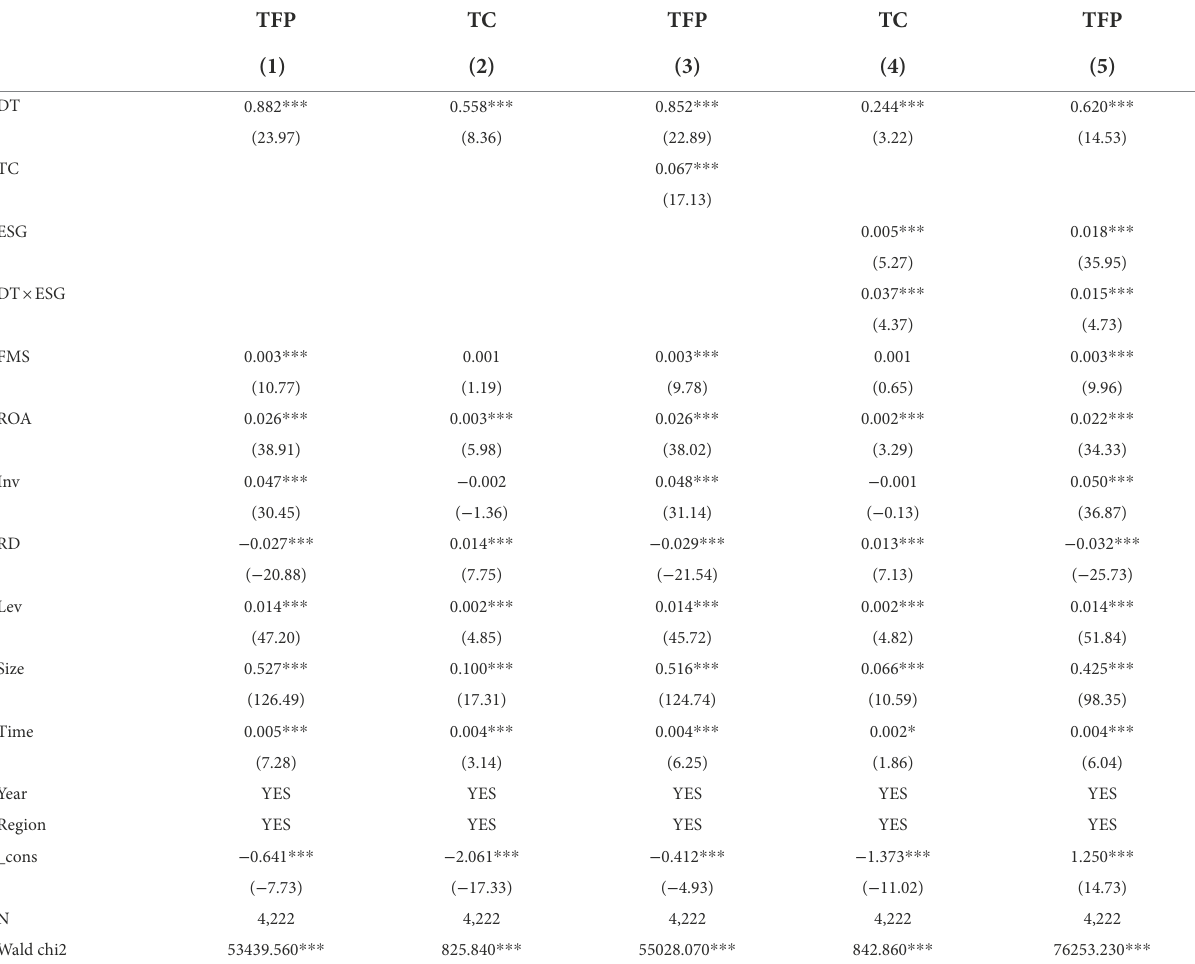
TABLE 3 Regression